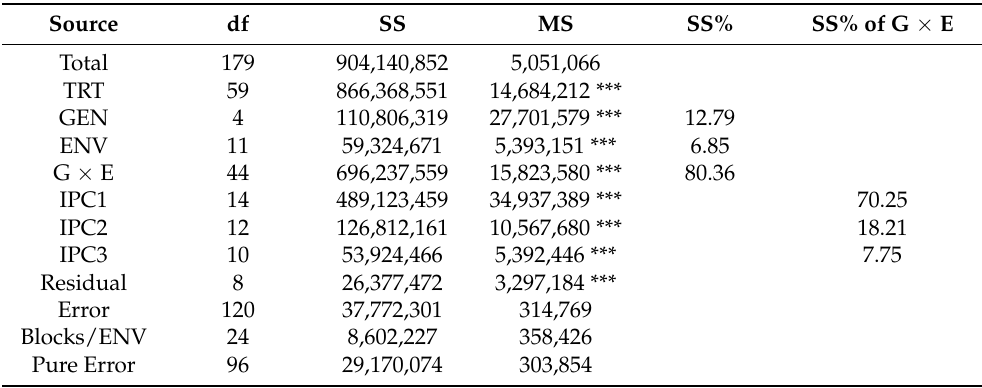
Table 4. Additive main effects and multiplicative interaction (AMMI) analysis of variance for grain yield